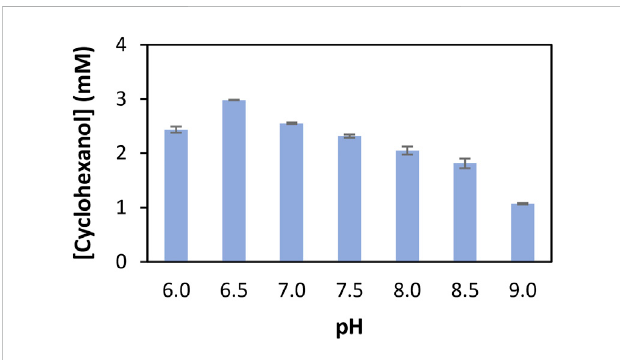
FIGURE 2 pH effect on conversion of cyclohexanone (15a) into cyclohexanol (15c) in ammonia-free buffer. Conditions: 100 mM NaPi buffer, pH 6.0 – 9.0, 12 mM glucose, 6 U mL − 1 GDH-105, .2 mM NADP +